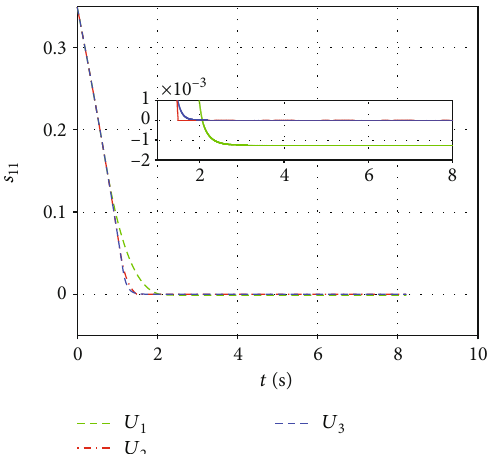
Figure 13: Dynamic error surfaces s